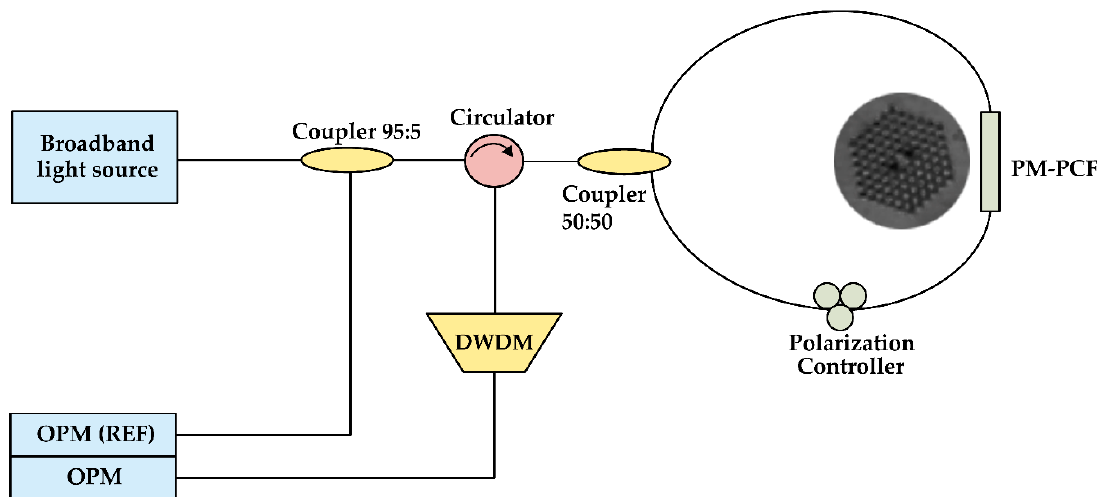
Figure 2. The scheme for the intensity-modulated PM-PCF based Sagnac loop strain sensor. Inset: The image of PM-PCF